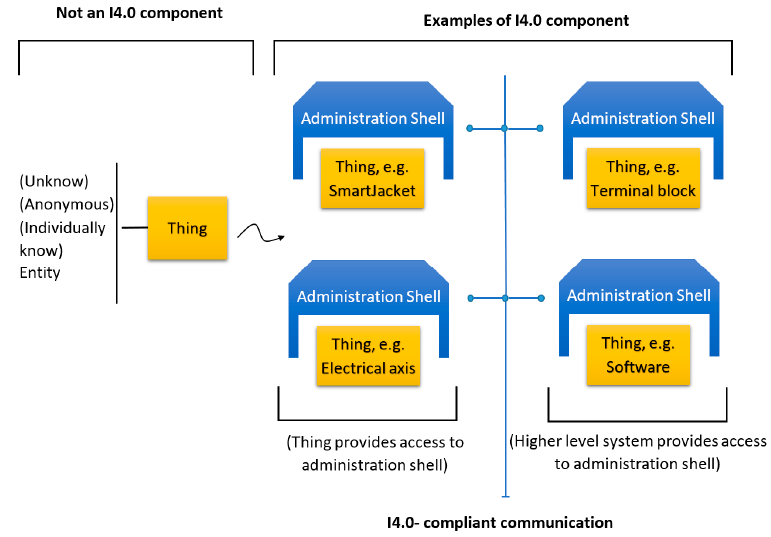
Figure 2. From an asset to the I4.0 component (inspired by ZVEI and VDI/VDE [17]).